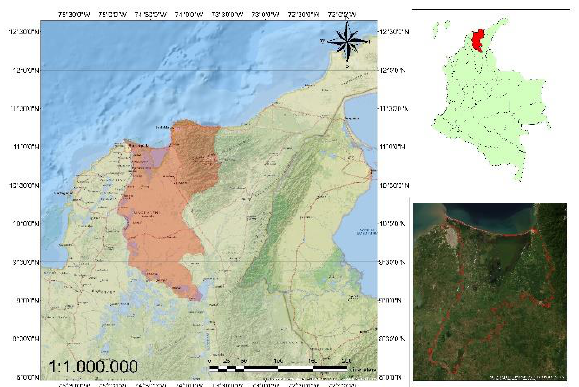
Fig. 1. Study area “Cienaga Grande, Santa